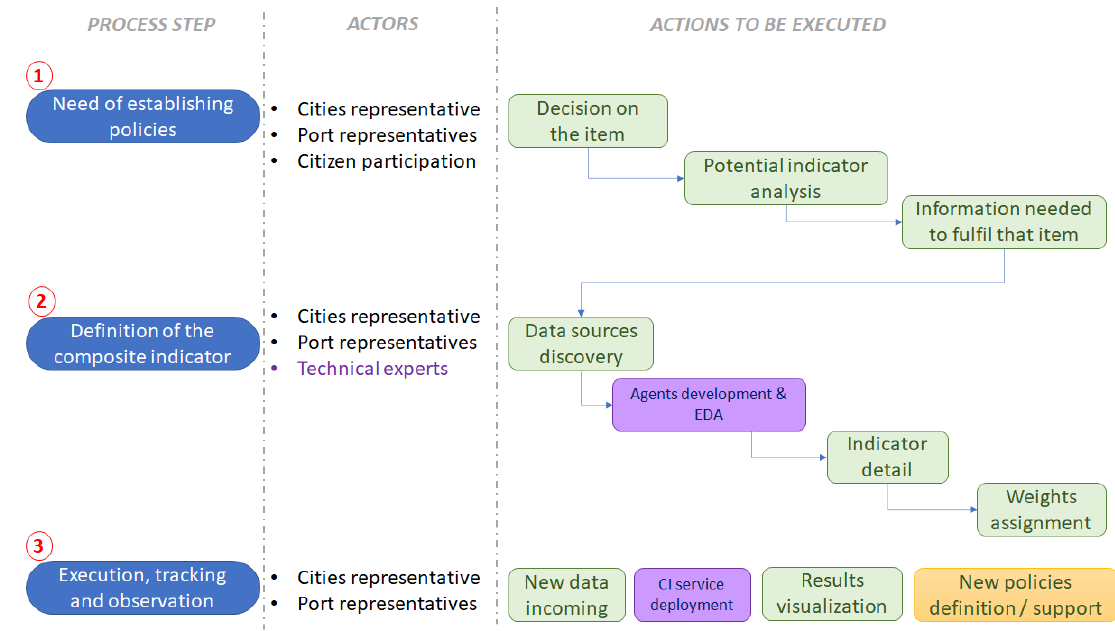
Figure 11. Conceptual methodology for deploying the framework on a practical experiment.